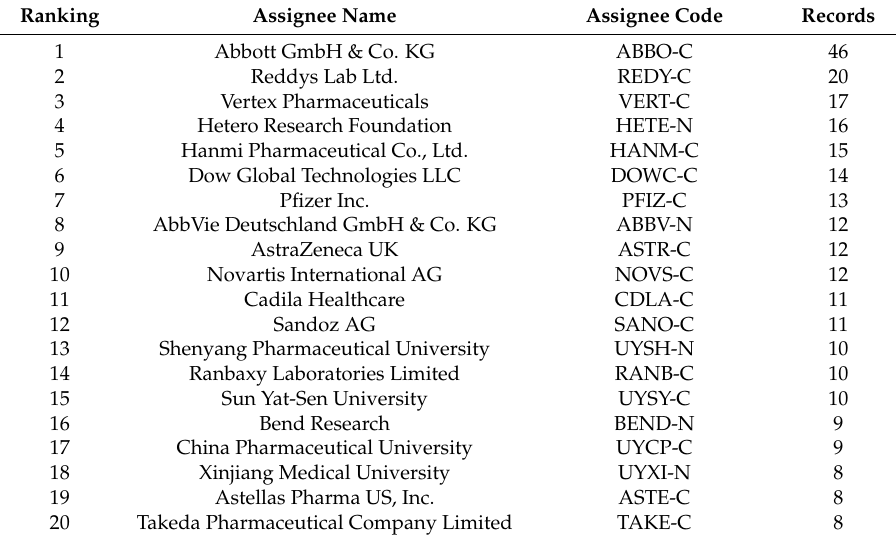
Table 3. Top 20 global